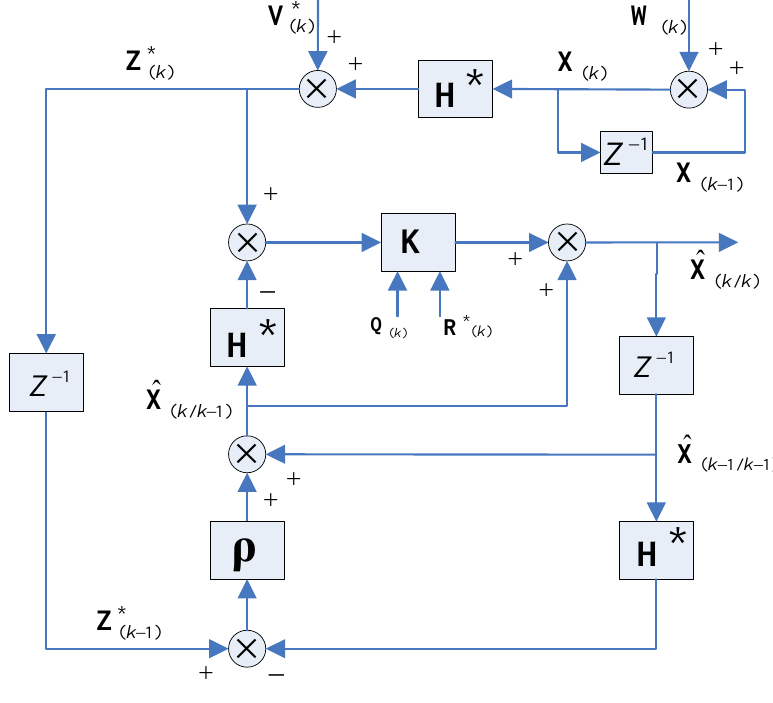
Figure 2. The structure of a robust KF for Jacobian matrix estimation. We introduce a filtering-revise-vector ρ to improve the robustness of the filter’s performance with ( k ) respect to universal dynamic